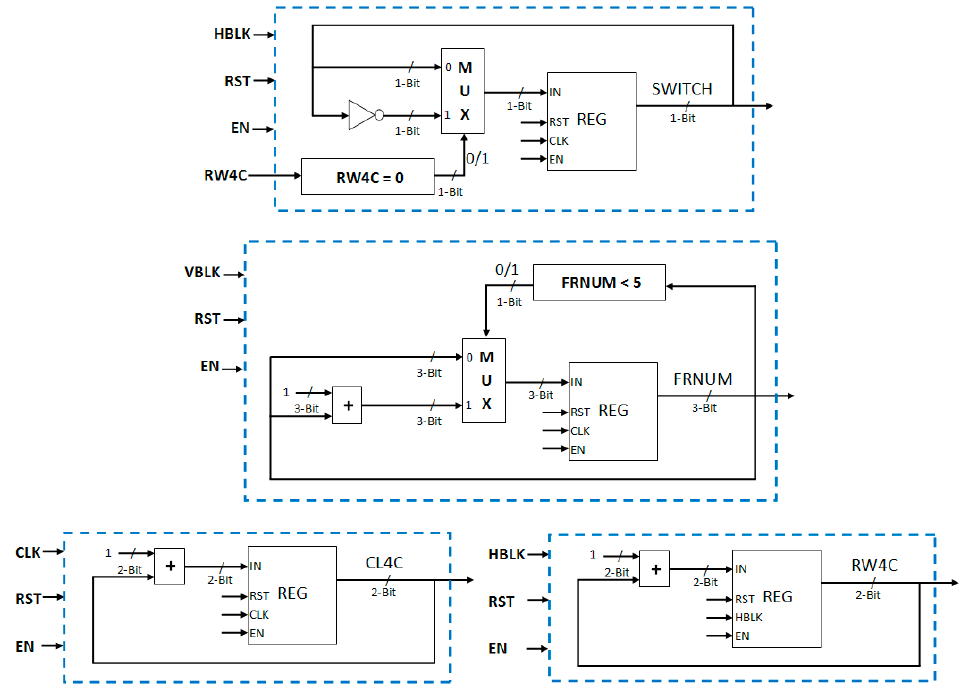
Figure 20. Logic modules to generate different control signals required for synchronization and proper functioning of complete motion detection system.